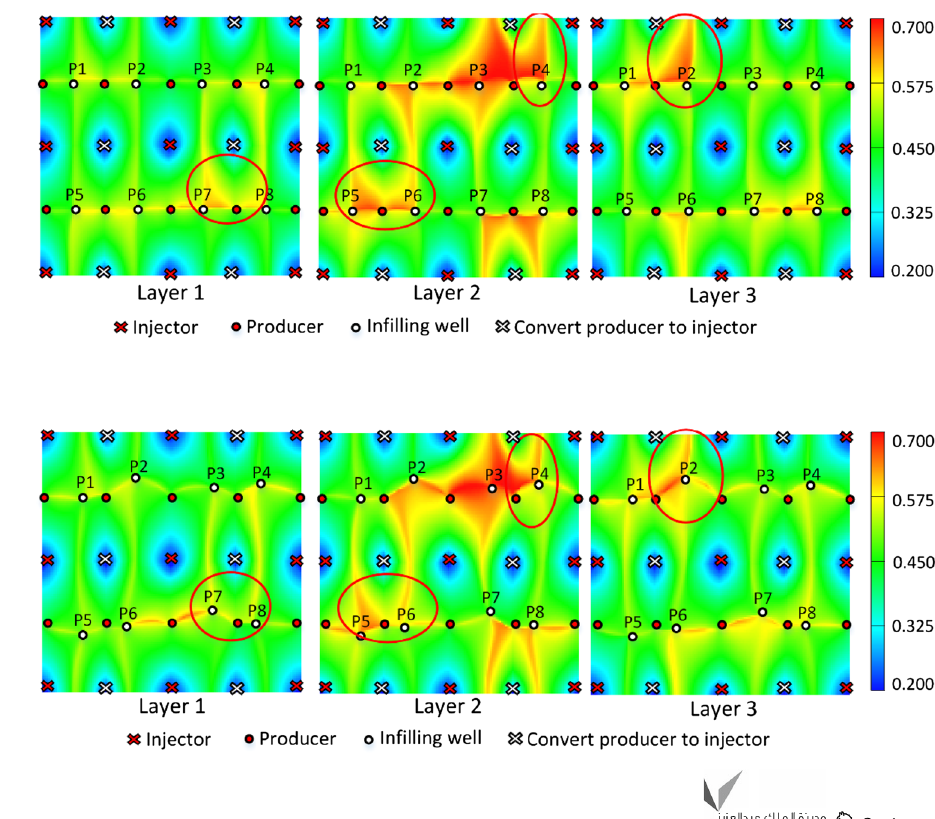
Fig. 6 Oil saturation distribution under regular infilling method